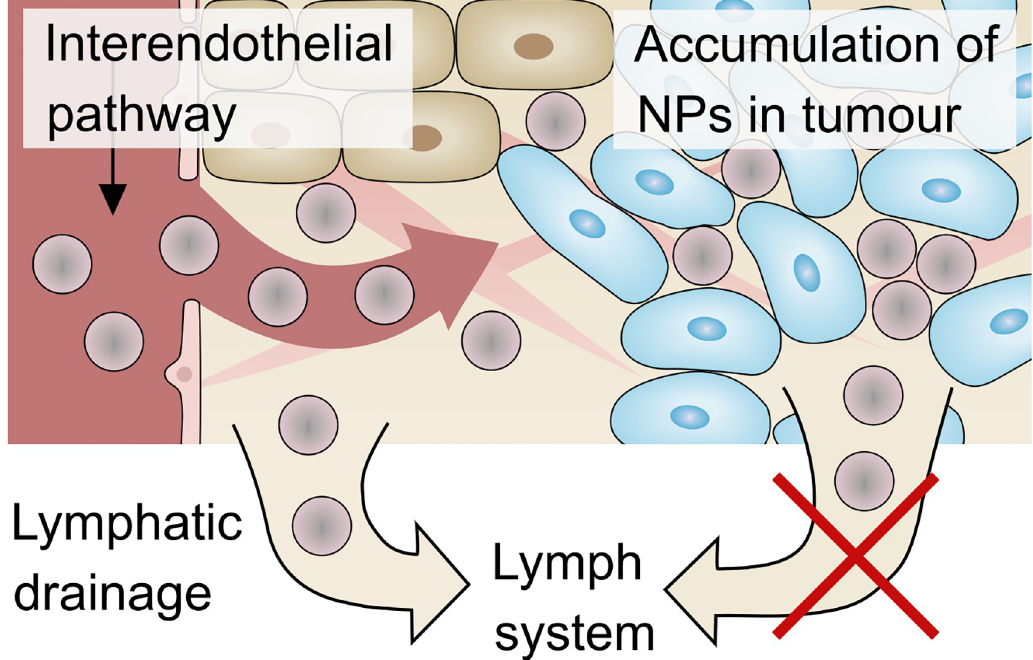
Fig 8. EPR effect. Nanoparticles (NPs) leak from the vasculature to the IF. In the tumour region, the lymphatic drainage is impaired and hence the particles are not removed by the lymph system. This results in a passive accumulation of nanoparticles in the tumour. This phenomenon is called the EPR (enhanced permeability and retention) effect [71].